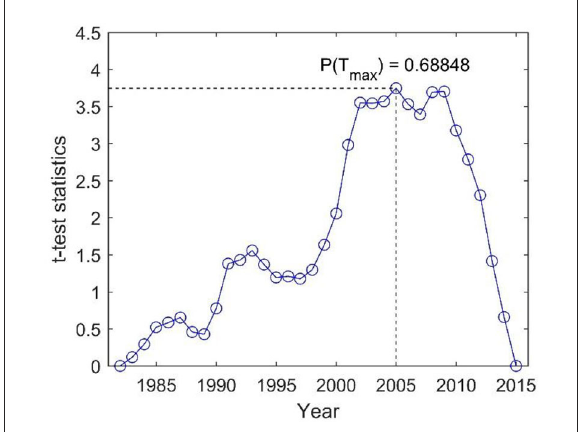
FIGURE3 The Bernaola-Galvan (BG) segmentation result of runoff depth in the Lancang River Basin (LCRB) from 1982 to 2015.